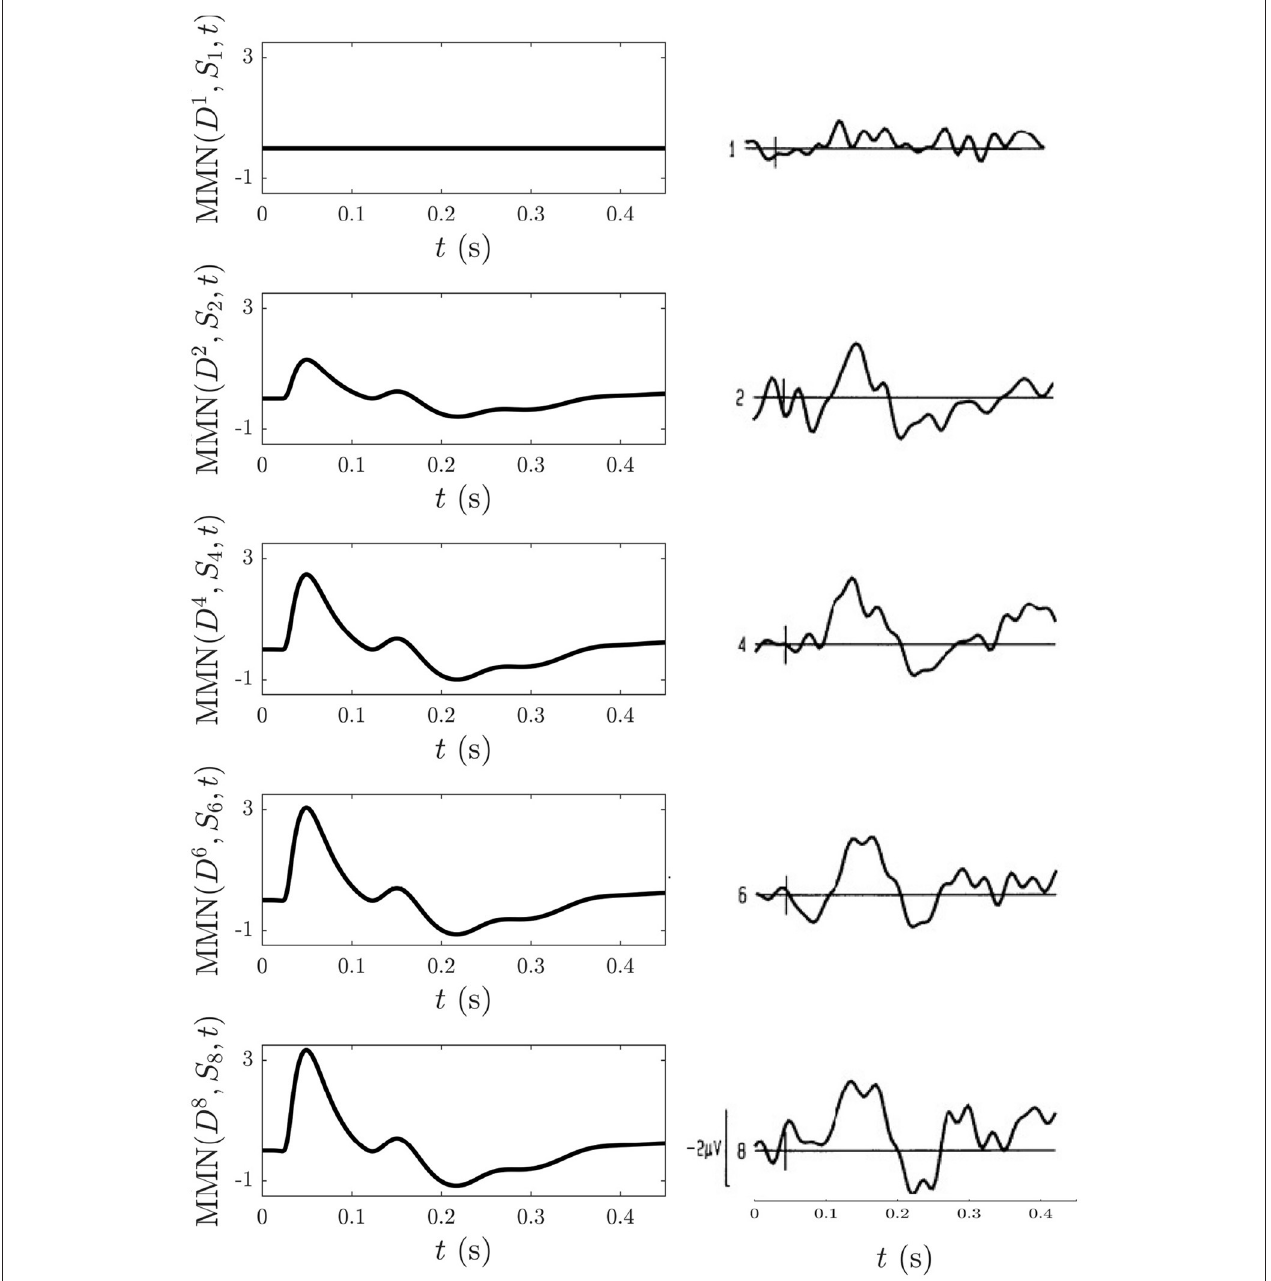
FIGURE 13 | Comparison of model simulations and experimental findings (Cowan et al., 1993) discussed in section 3.4.5. Simulation of the MMN( D n , S n , t ) for n 1,2,4,6,8 is shown on the left and the corresponding experimental MMN curves adapted from Cowan et al. (1993) on the right. The small vertical mark in each = experimental frame indicates the stimulus time and the first curve gives an indication of noise